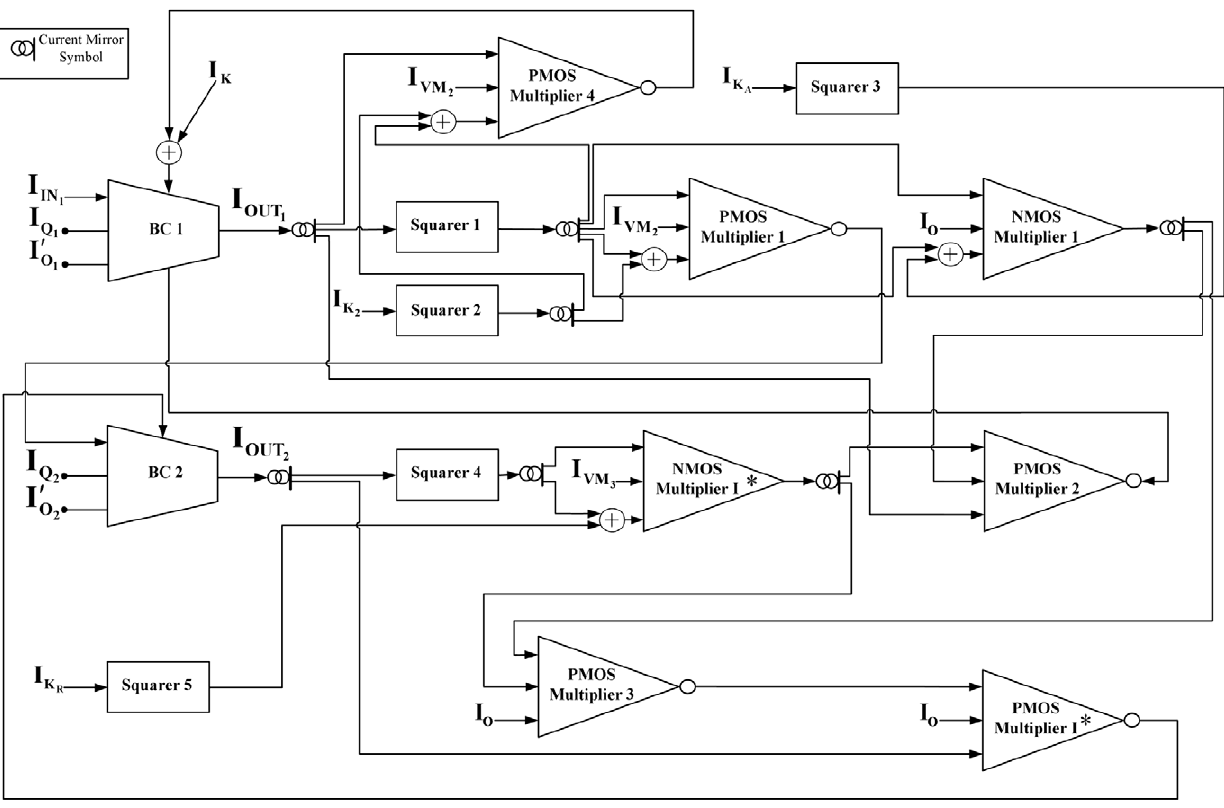
Figure 6. A block representation of the total circuit implementing intracellular Ca 2 + oscillations for the case with Hill coefficients m ~ n ~ p ~ 2 as codified by (28) & (29). Two TL blocks have been selected in a non-cascoded form to provide circuit stability for low power supply.